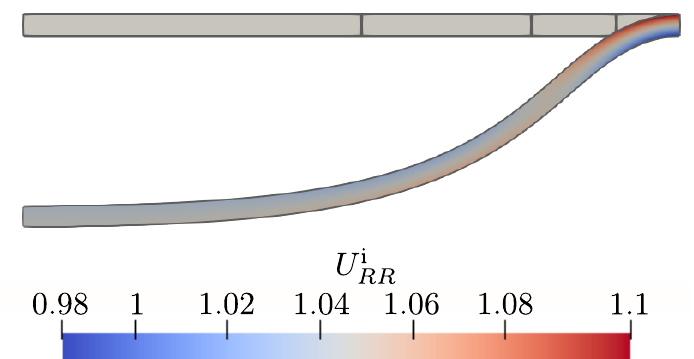
Figure 3. Coarse finite element mesh in the reference configuration together with radial inelastic stretch in the deformed configuration at t = t e (result obtained with m t = 0 and m h = 6).